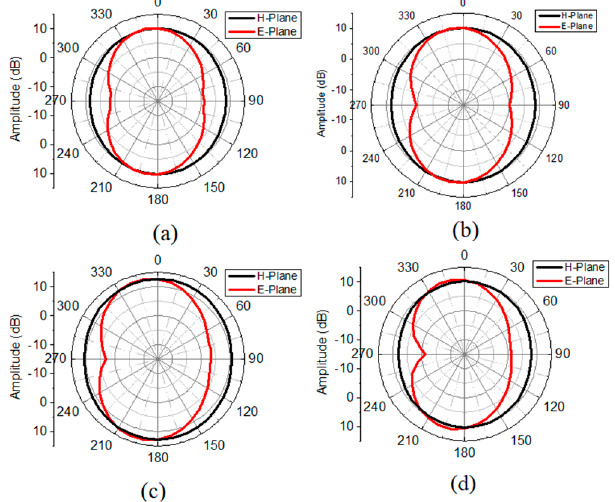
Figure 7. Radiation patterns of the proposed resonator based continuously tunable dual band ‐ notched antenna at Cap1 = 0.1 pF ( a ) 3.5 GHz (simulated); ( b ) 5.9 GHz (measured); ( c ) 8.1 GHz (measured); ( d ) 10 GHz (simulated).